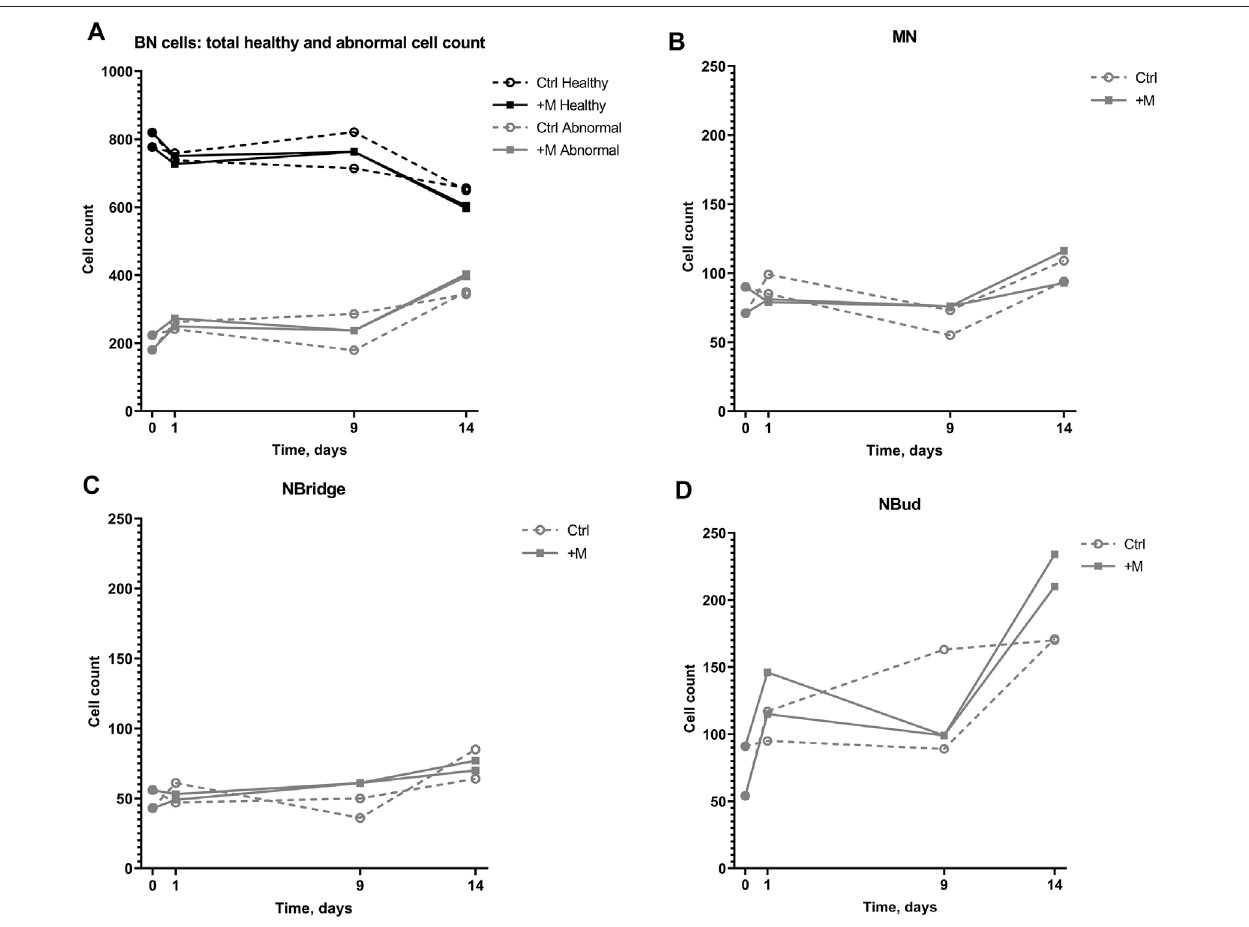
FIGURE 5 | Genotoxic effect on 1000-cell samples of CHO suspension cells cultivated under 0.66-T static MF exposure for 14 days. (A) Numbers of binucleated (BN)cellswithnochromosomaldamage(Healthy)andBNcellswithdetectedchromosomaldamage(Abnormal)with(+M)andwithout(Ctrl)magnetic fi eldexposure; (B) numbers of BN cells with MN; (C) numbers of BN cells with NBridge; (D) numbers of BN cells with NBuds.